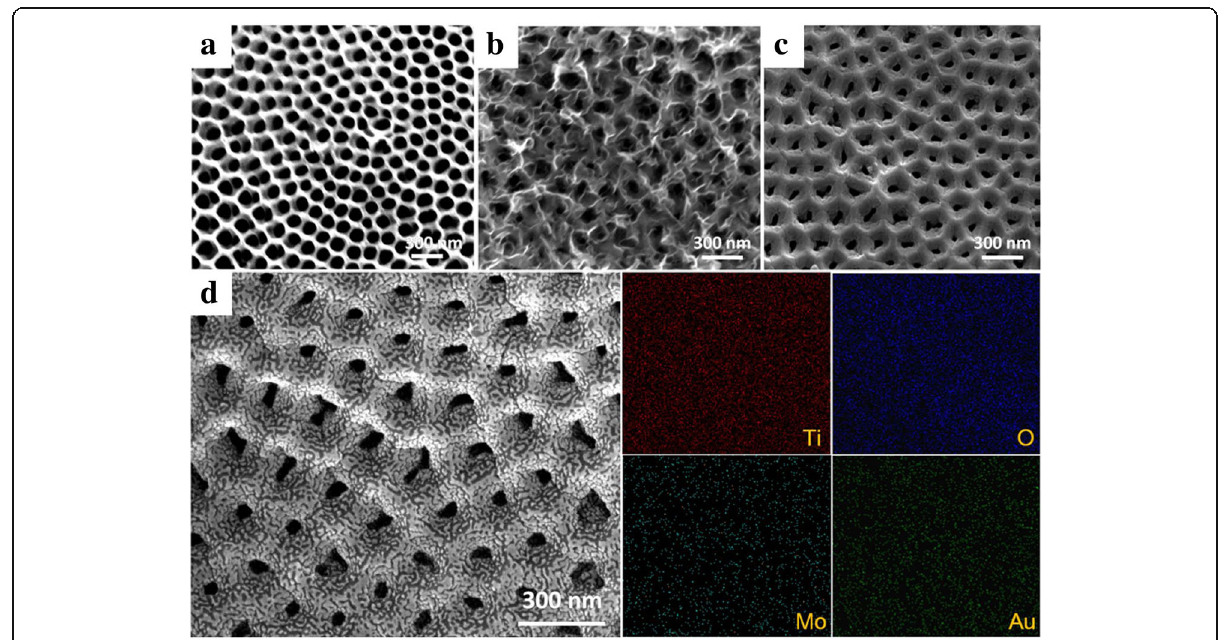
Fig. 1 SEM images of a TNTs, b TNTs@MoS 2 , c TNTs@MoO 3 , and d Au/TNTs@MoO 3 (left), as well as EDS mapping